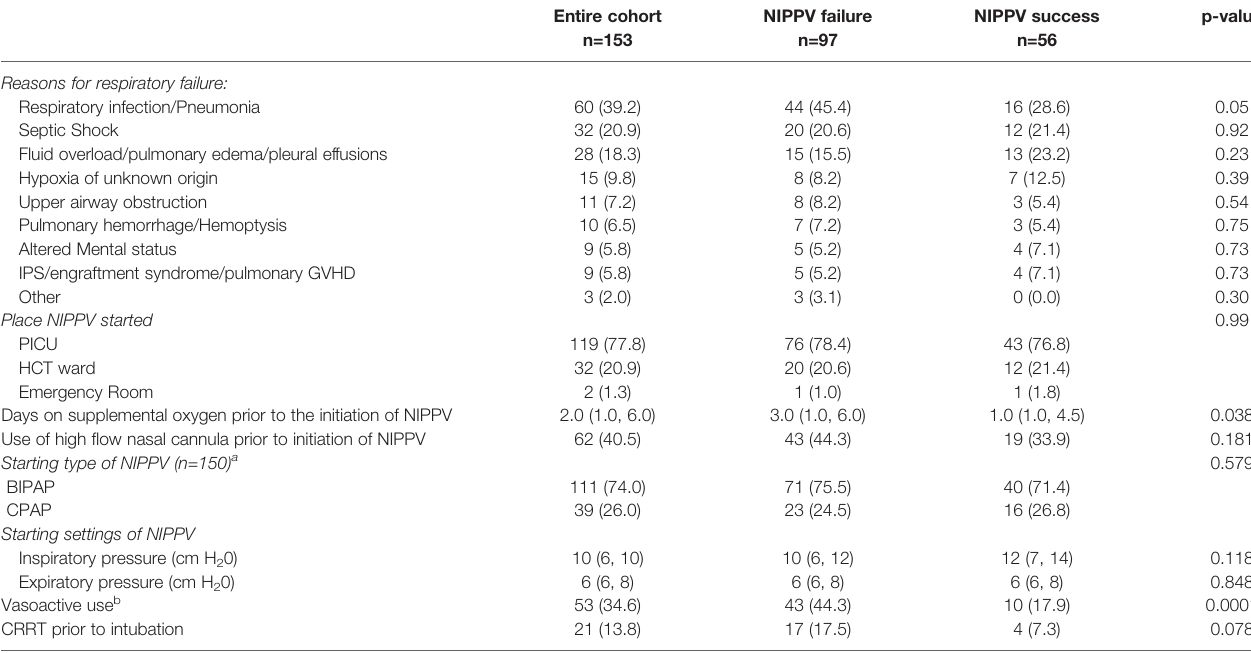
TABLE 2 | Patient characteristics at NIPPV initiation strati fi ed by failure or successful use of noninvasive positive pressure